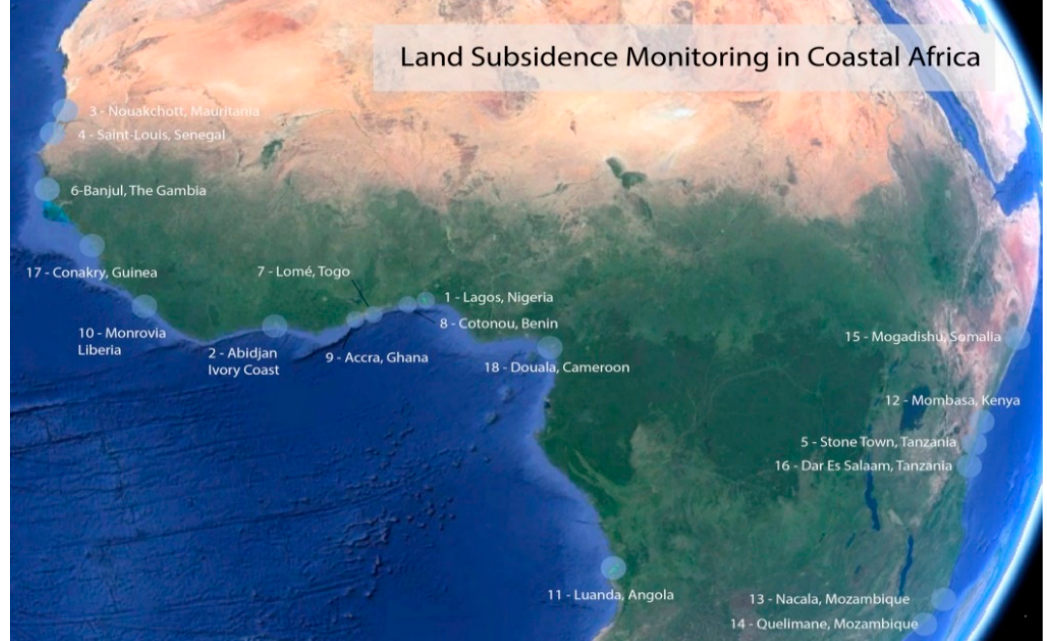
Figure 1. Case studies for which land subsidence was assessed within the City Coastal Resilience project.